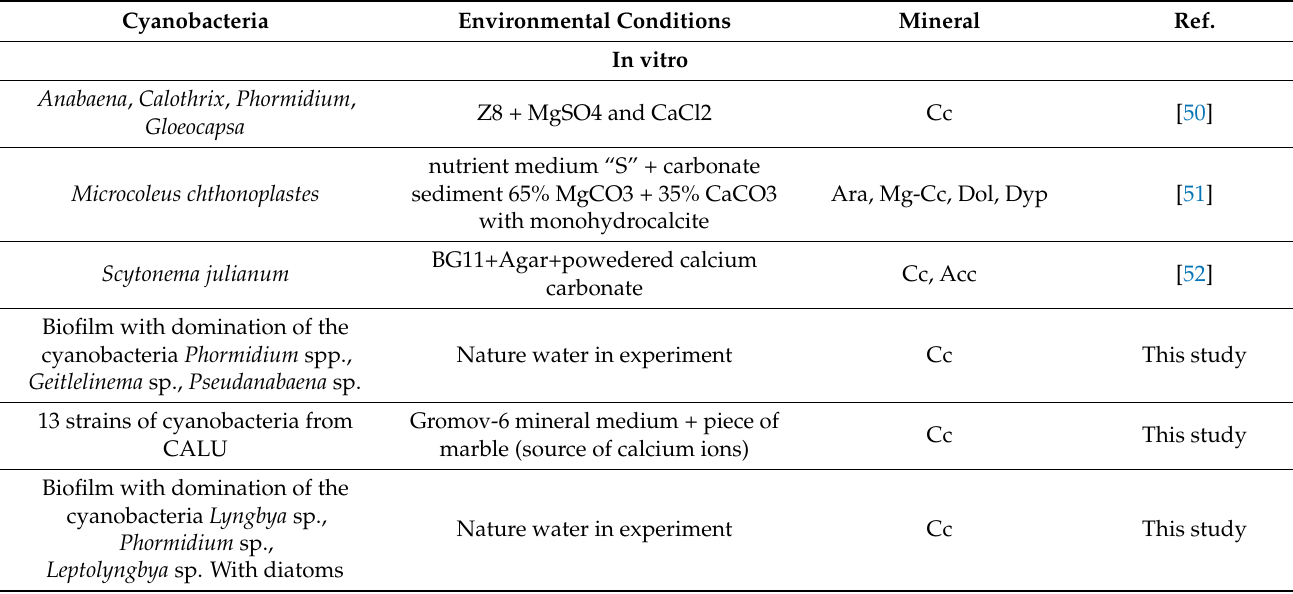
Figure 9. SEM images of carbonate sediments formed in 9-month experiments with cyanobacterial strains: ( a )—single spherical globules in the Calothrix sp. trichomes, scale bar 30 µ m; ( b )—dumbbell-shaped calcite crystals from Pseudanabaena sp. culture, scale bar 30 µ m; ( c )—spirally wrapped calcite on the Lyngbya aerugineocoerulca f. minor trichomes, scale bar 100 µ m; ( d )—thick carbonate covers around the Oscillatoria formosa , scale bar 30 µ m. Note: CS—calcite sediments; CT— carbon tape; BF—cyanobacterial biofilm; H—holes; cavities in sediments formed by cyanobacterial trichomes; Gl—globules. Table 6. The participation of cyanobacteria in the carbonate sedimentation in fresh and mineralized water in nature and in